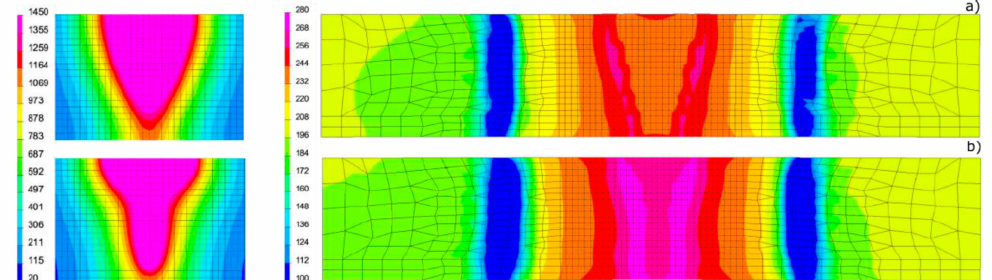
Figure 18. View of the molten pool and von Mises stresses distribution in the case of calculations for ( a ) the model without modification of the area of mesh elements loaded with the heat source model and ( b ) the model based on the proposed calculation modification for the DL_T3 sample (Table 3).